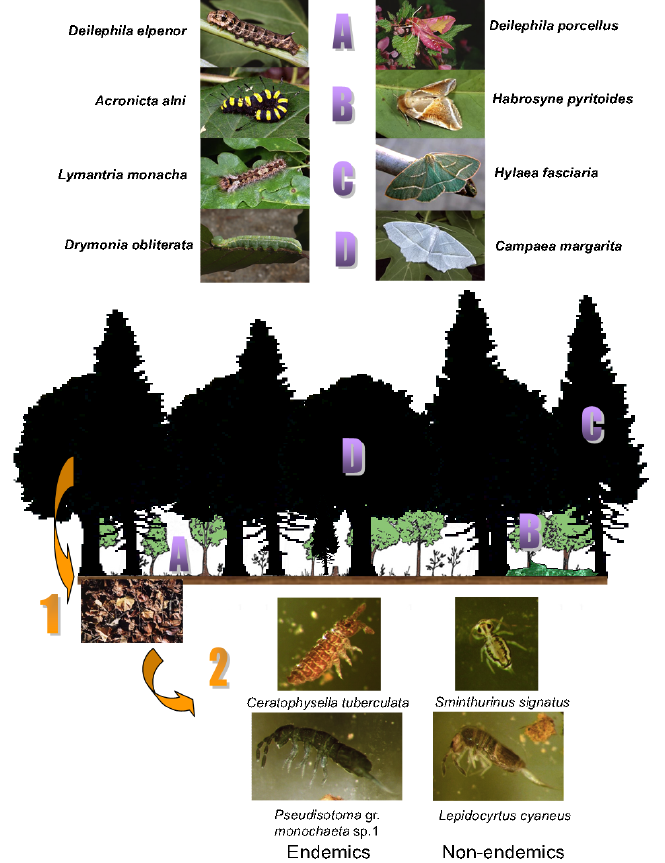
Figure 1. Distribution of the two marker groups in the forest